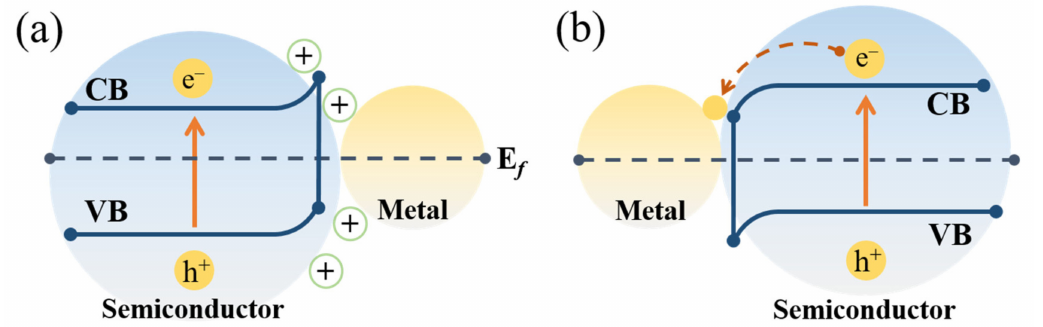
Figure 7. The schematic of the metal–semiconductor heterojunction: ( a ) ϕ m > ϕ s and ( b ) ϕ m < ϕ s